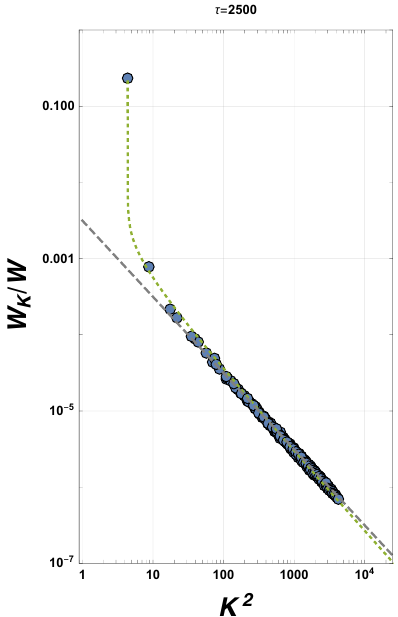
Figure 12. Case B - viscous. Time averaged W K / W as in the right-hand panel of Figure 11: the gray dashed line is again the behavior ∼ 1/ K 2 , while the green dotted line indicates the logarithmic correction of Equation (37), i.e., the line ∼ K − 2 ( ln [ K / K i ]) − 1/3 , with K 2